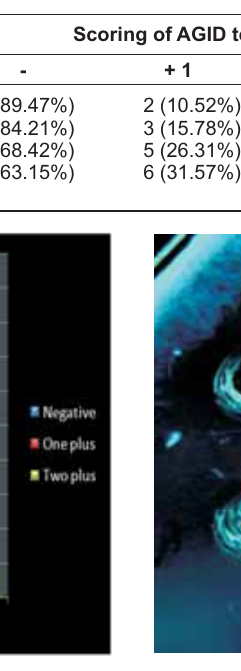
Figure-3: Graph for AGID test in percentage score recorded during the study period.